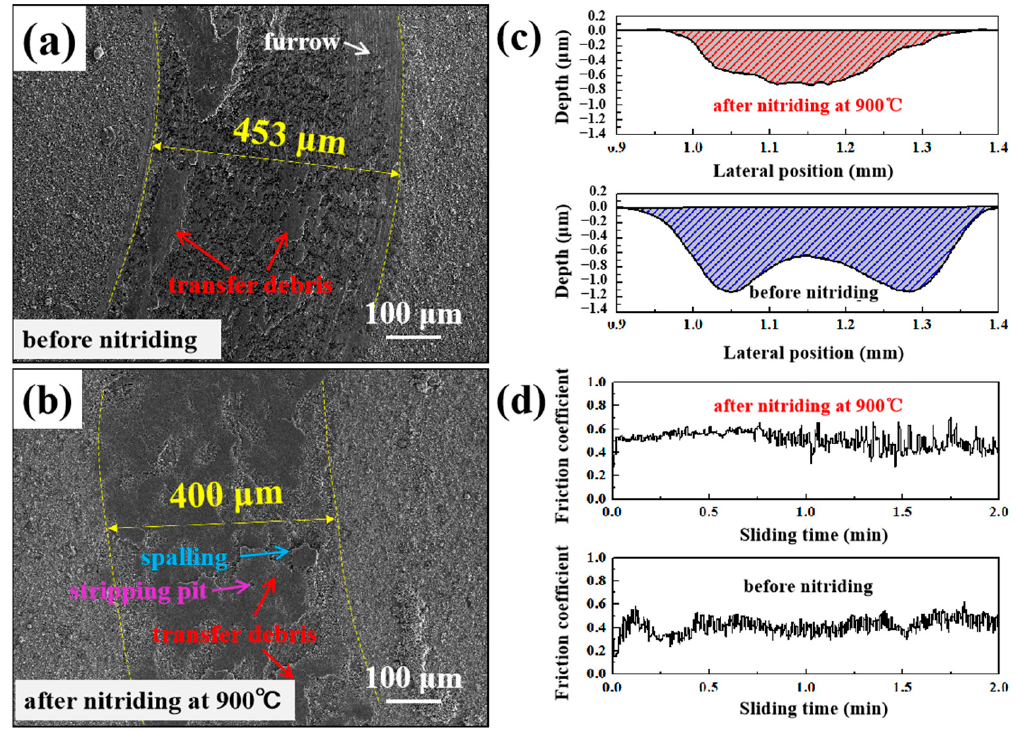
Figure 5. The tribological properties of the Ti/Cu multilayer film before and after nitriding: ( a , b ) wear track morphologies, ( c ) wear track profile, ( d ) friction coefficient.